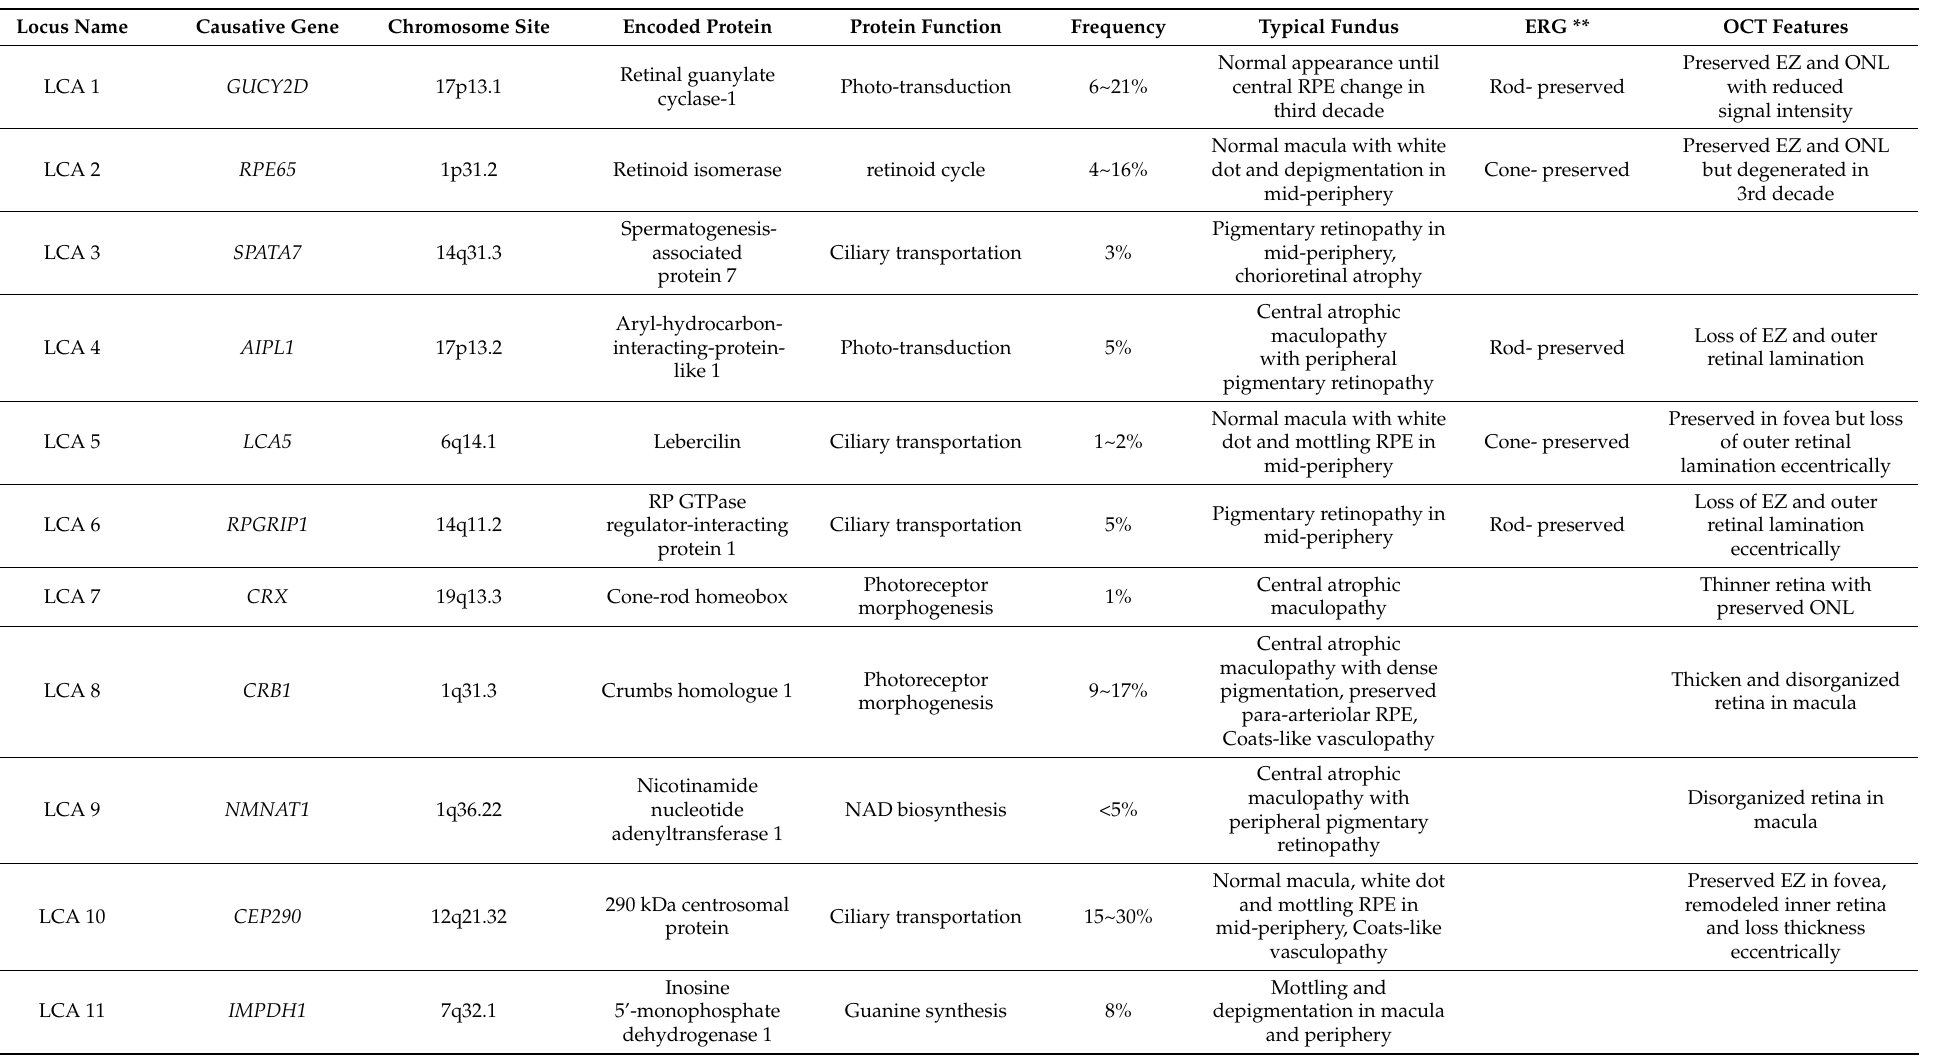
Table 1. Overview of the genes responsible for LCA and their clinical presentation, including the common funduscopic features, exception in ERG, and findings in OCT